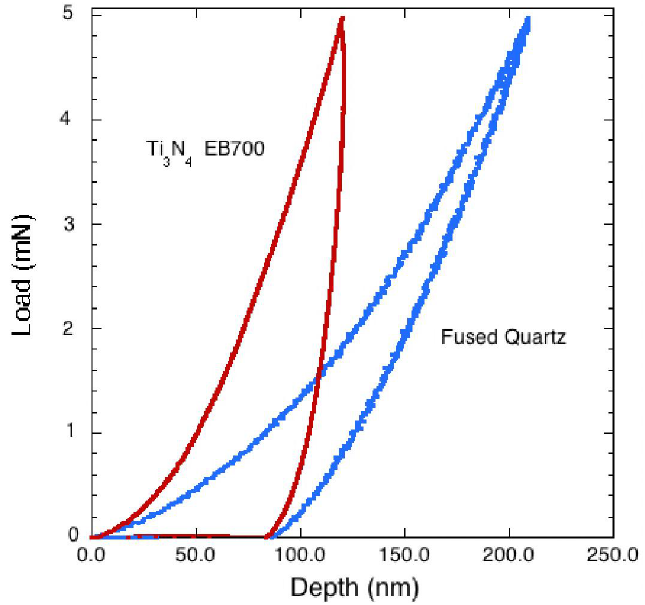
Figure 2. Typical load-depth trace obtained during nanoindentation for sample EB700 up to 5 mN compared with a fused quartz standard. The amorphous/nanocrystalline Ti N sample exhibits significantly more stiffness while deforming, however, its residual 3 4 indentation depth on recovery is nearly the same as that of the quartz glass